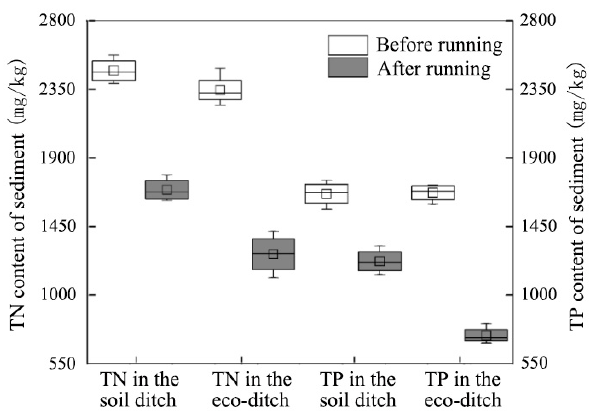
Figure 6. Changes of N and P concentration of sediments before and after experiments in the eco-ditch and the soil ditch.